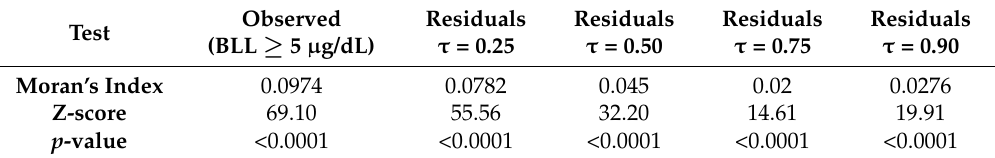
Table 4. Moran’s I for the observed incident rate of children’s BLL ≥ 5 µ g/dL and the residuals of global quantile regression